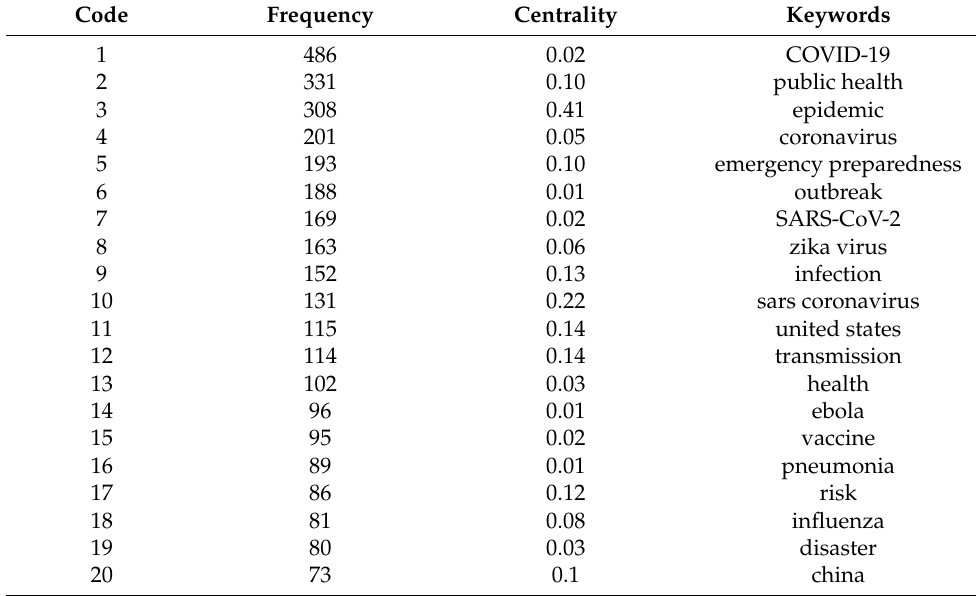
Figure 5. Co-occurrence network (1994–2020). A node corresponds to a keyword. The larger the node, the higher the frequency of keyword reference. The ring around the node represents the frequency of keyword occurrence in different years, and the color of different depths represents different years. The thickness of the ring is directly proportional to the frequency of the word in that year, and the line between nodes represents the degree of connection between keywords. Table 4. Glossary of hot topics in the PHE